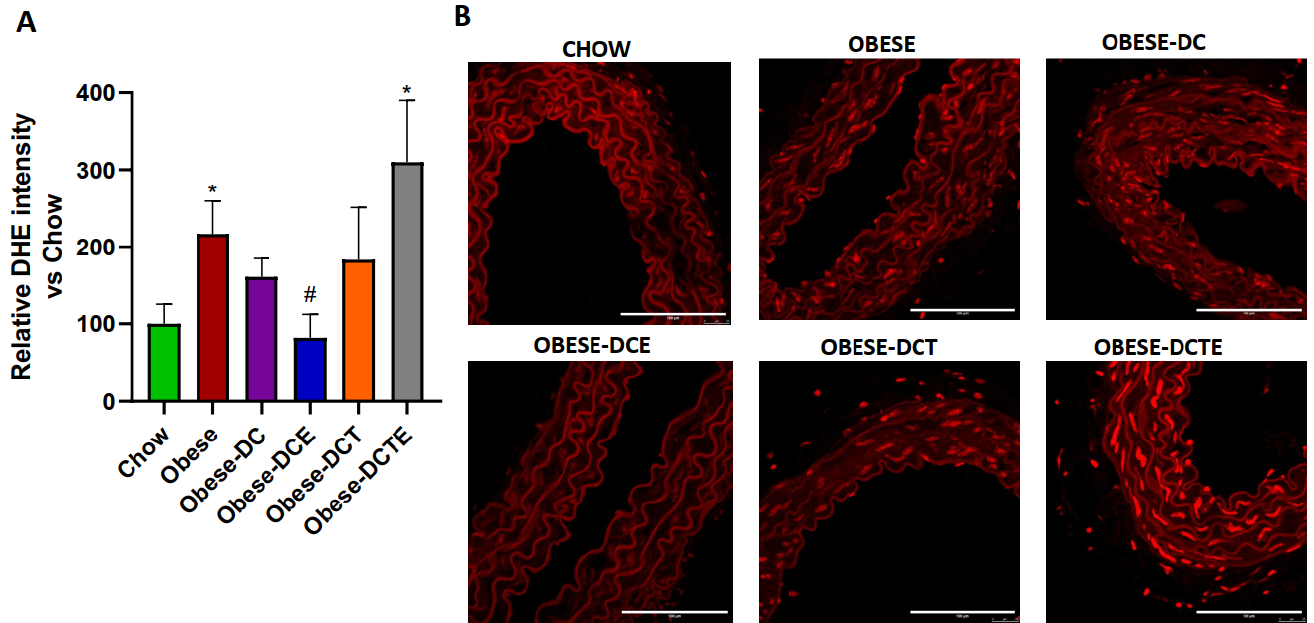
Figure 10. Quantification of reactive oxygen species ( A ) and representative images of aorta sections stained with dihydroethidium ( B ). The scale bar is equivalent to 100µm. Chow = mice fed a standard diet for 25 weeks; Obese = mice fed a high fat (60% kcal from fat)/high sucrose diet for 25 weeks; DC = mice fed a high fat (60% kcal from fat)/high sucrose diet for 23 weeks and switched to a diet with lower caloric intake (25% kcal from fat) for two weeks; DCE = mice fed a high fat (60% kcal from fat)/high sucrose diet for 23 weeks and switched to a diet with lower caloric intake (25% kcal from fat) supplemented with CSAT+ ® for two weeks; DCT = mice fed a high fat (60% kcal from fat)/high sucrose diet for 23 weeks and switched to a diet with lower caloric intake (25% kcal from fat) and subjected to aerobic training for two weeks; DCTE = mice fed a high fat (60% kcal from fat)/high sucrose diet for 23 weeks and switched to a diet with lower caloric intake (25% kcal from fat) supplemented with CSAT+ ® and subjected to aerobic training for two weeks. Values are represented as mean ± SEM; n = 8–10 mice/group. * p < 0.05 vs. chow; # p < 0.05 vs. obese.